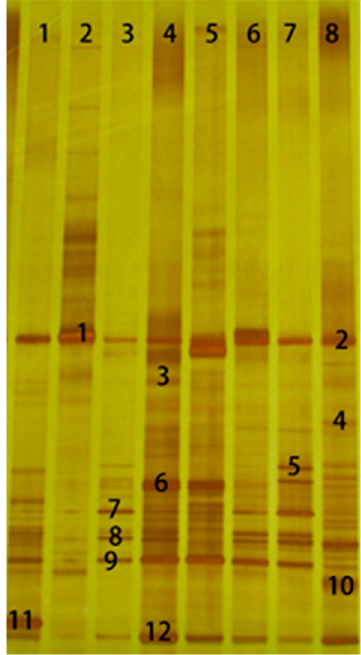
Figure 2 . DGGE analysis of PCR-amplified 16S rDNA fragments of Lolium multiflorum Lam. silage after 60 days fermentation. Lane 1, control group at 35% DM; lane 2, formic acid group at 35% DM; lane 3, LP-treated group at 35% DM; lane 4. LB-treated group at 35% DM; lane 5, control group at 25% DM; lane 6, formic acid group at 25% DM; lane 7, LP-treated group at 25% DM; lane 8, LB-treated group at 25% DM. Table 5 . Sequences analysis of DNA recovered from single band in DGGE fingerprints of Lolium multiflorum Lam. silage after 60 days of fermentation .